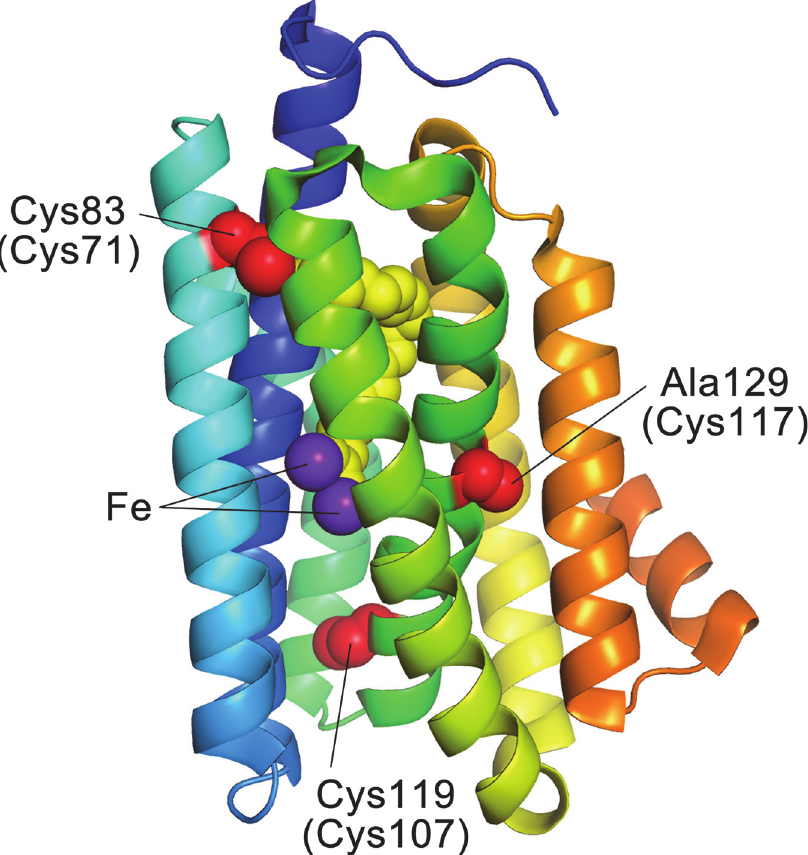
Fig 1. Crystal structure of Prochlorococcus marinus MIT9313 aldehyde deformylating oxygenase ( Pm AD). Cys83, Cys119, and Ala129 in Pm AD, which corresponds to Cys71, Cys107, and Cys117 in AD from Nostoc punctiforme PCC 73102 ( Np AD), respectively, are shown as red space-fill models (PDB ID: 2OC5). The two iron atoms and the substrate are shown as purple and yellow balls, respectively. The α - helices neighboring the helix involving Cys71 (cyan) are shown in blue and yellow-green. The figure was drawn using the PyMOL Molecular Graphics System, Schrödinger,